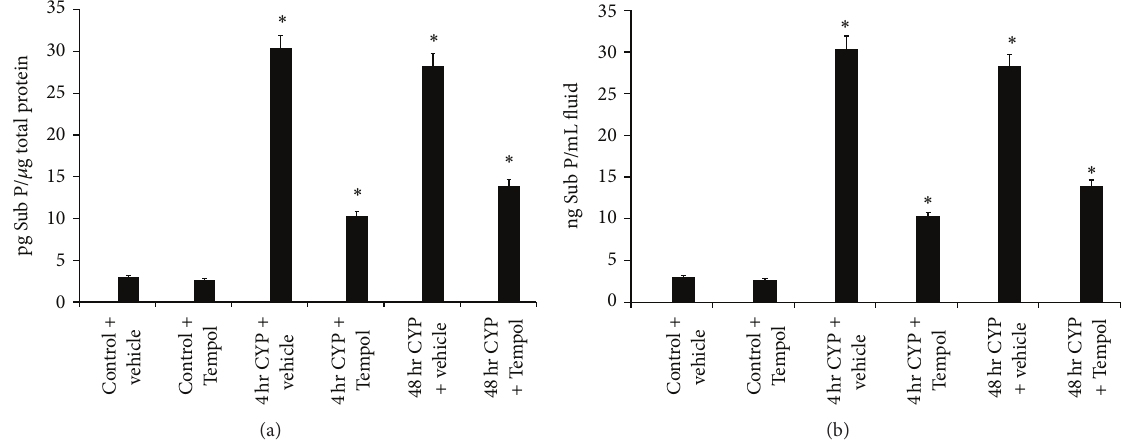
Figure 2: Cyclophosphamide- (CYP-) induced cystitis increases substance P (Sub P) in the urinary bladder and cystometric fluid and the antioxidant, Tempol, reduces expression. (a) 4hr and 48 hr CYP-induced cystitis significantly ( 𝑃 ≤ 0.01 ) increased Sub P expression in urinary bladder that was significantly reduced with Tempol. Tempol was without effect on Sub P expression in urinary bladder from control (no CYP) rats. (b) 4 hr and 48hr CYP-induced cystitis significantly ( 𝑃 ≤ 0.01 ) increased Sub P expression in cystometric fluid that was significantly ( 𝑃 ≤ 0.01 ) reduced with Tempol. Tempol was without effect on Sub P expression in cystometric fluid from control (no CYP) rats. ∗ 𝑃 ≤ 0.01 . 𝑛 = 6 for control and treatment